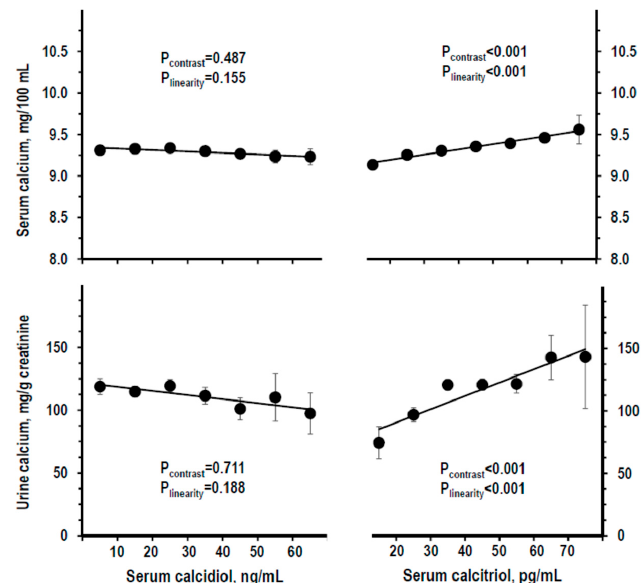
Figure 2. Mean ± SE of serum calcium (top panels) and of urine calcium / creatinine ratio (lower panels) by stratum of serum calcidiol (left panels, recalibrated data) and of serum calcitriol (right panels). Strata were defined as in Figure 1. The stratum with serum calcidiol ≥ 70 ng / mL and the stratum with serum calcitriol < 10 pg / mL were combined with the next stratum to avoid the bias due to low n ( n = 3). Number of persons per stratum from left to right: For calcidiol = 164, 357, 253, 122, 53, 18, and 12; for calcitriol = 38, 193, 355, 255, 106, 24, and 8. p -values by non-adjusted ANOVA. p -values were considered statistically significant when < 0.025. The line shows the linear trend along strata.